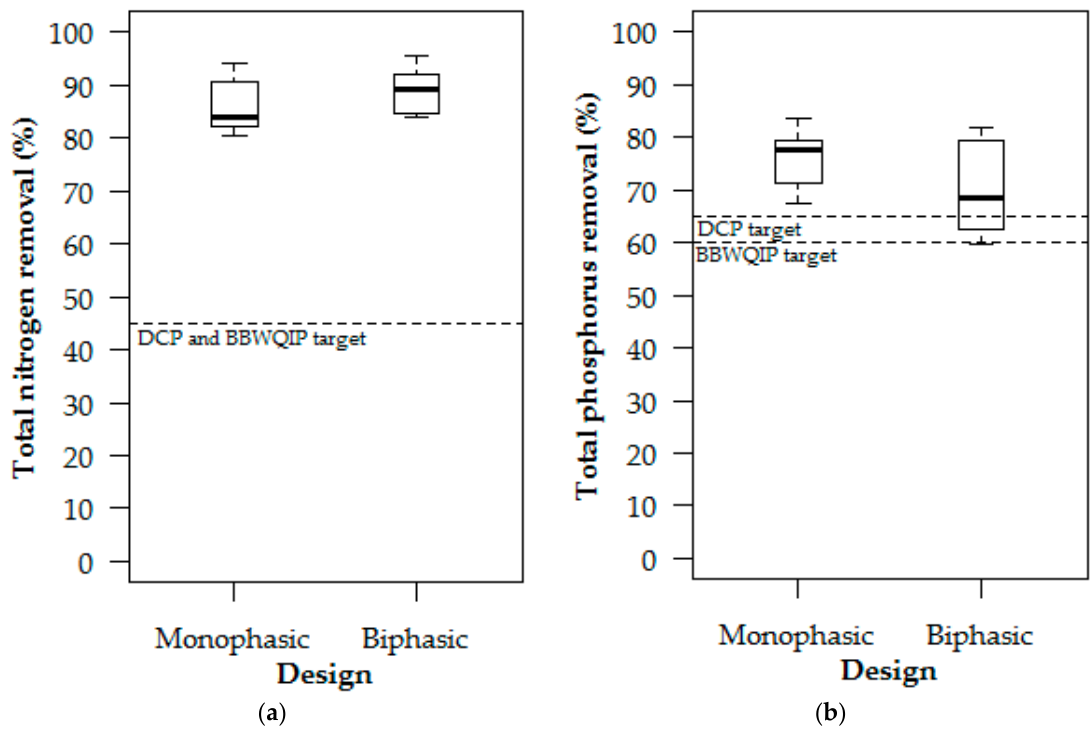
Figure 4. Median nutrient removal efficiency by design type: ( a ) total nitrogen (TN); ( b ) Total phosphorus (TP).